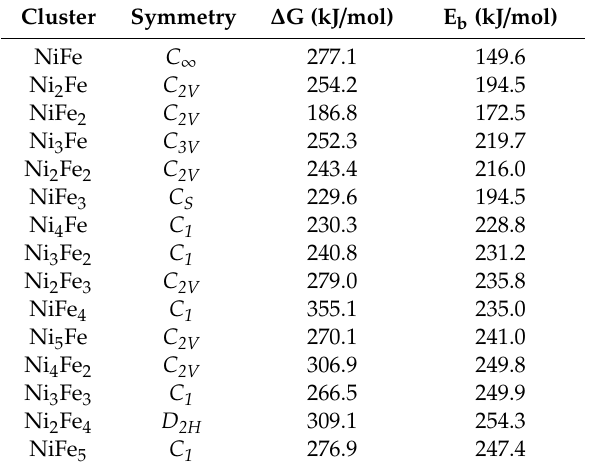
Table 1. Characteristics of calculated Ni a Fe b (2 ≤ a + b ≤ 6) clusters.